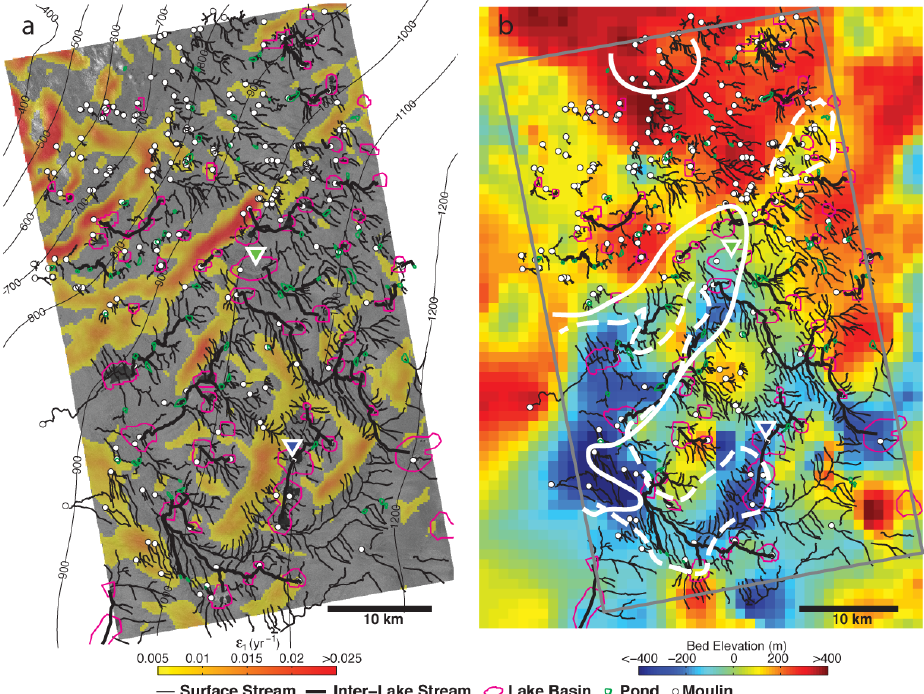
Fig. 2. (a) TerraSAR-X image (copyright DLR 2009) showing study area over-plotted with surface hydrological features. Color indicates principal surface strain rates for magnitudes approximately sufficient to cause crevassing, and contours show surface elevation. Streams were hand-digitized from high-resolution WorldView imagery; only a small fraction of the streams visible in the imagery are shown (see Methods). Triangles show the locations of GPS stations adjacent to North and South lakes. (b) Basal topography (Bamber et al., 2013) is overplotted with surface hydrological features. Although the digital elevation model is posted at 1km, it was generated from sparse flights separated by many kilometers, so the true resolution is variable and much poorer than 1km. White lines indicate approximate extent of the areas where speedup exceeded 100% on 15 July 2009 (dashed) and 10 June 2010 (solid) as indicated by the data shown in Figs. 3 and 4,